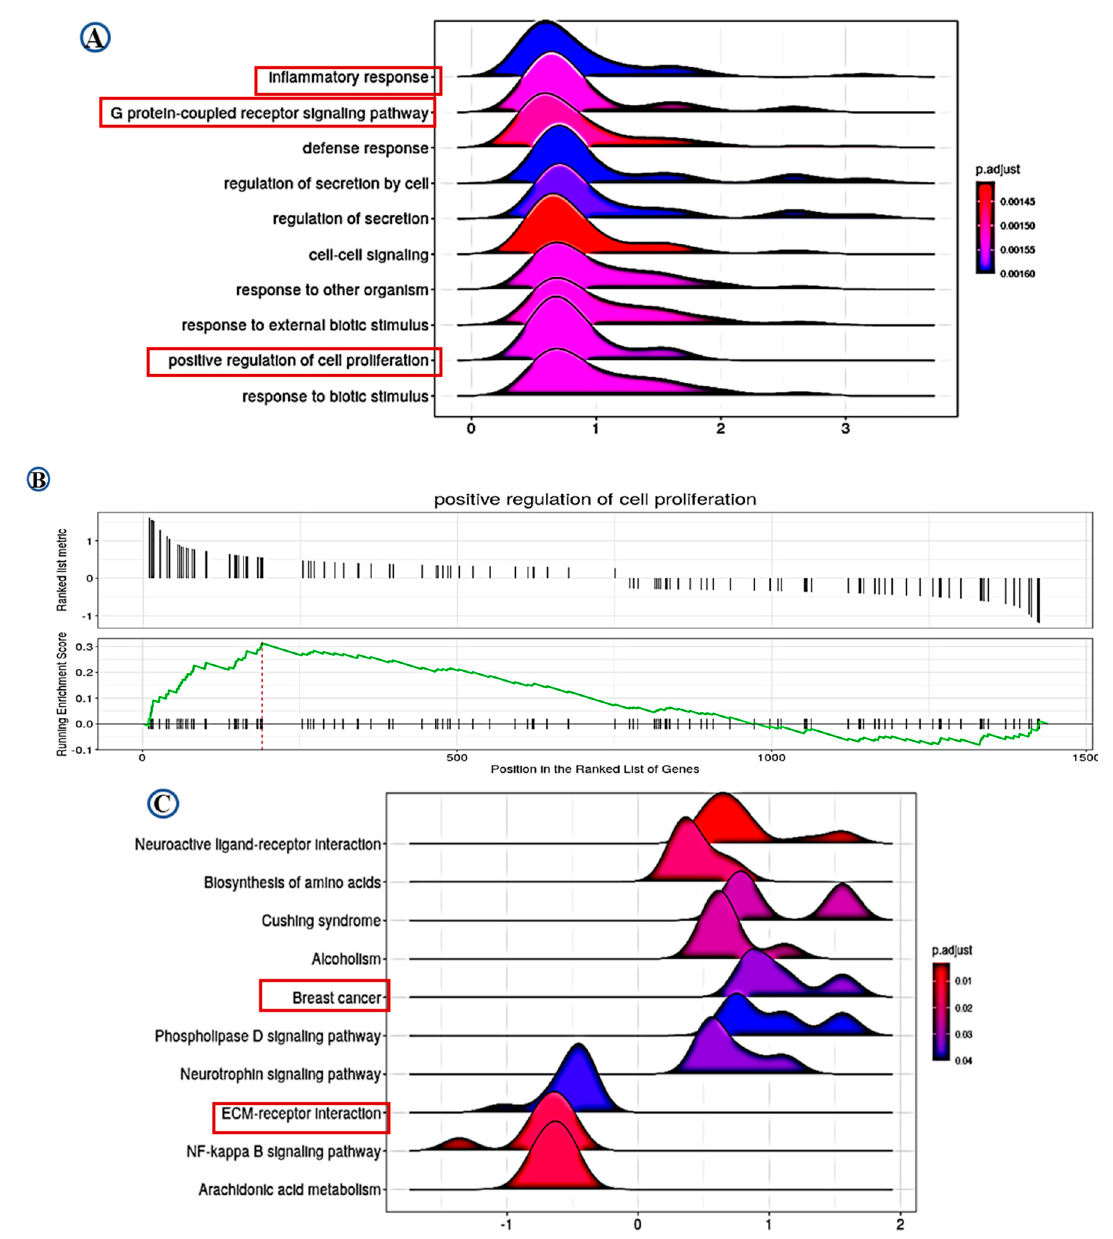
Figure 6. Data of gene ontology (GO) and Kyoto Encyclopedia of Genes and Genomes (KEGG) analysis. Based on the LAIR-1 correlated genes, the enriched information about gene ontology (GO) pathway ( A , B ), and the data of KEGG ( C ) were provided, respectively. All pathways mainly highlighting LAIR-1 association with extracellular matrix (ECM)-receptor interaction and positive regulatory role in cell proliferation.